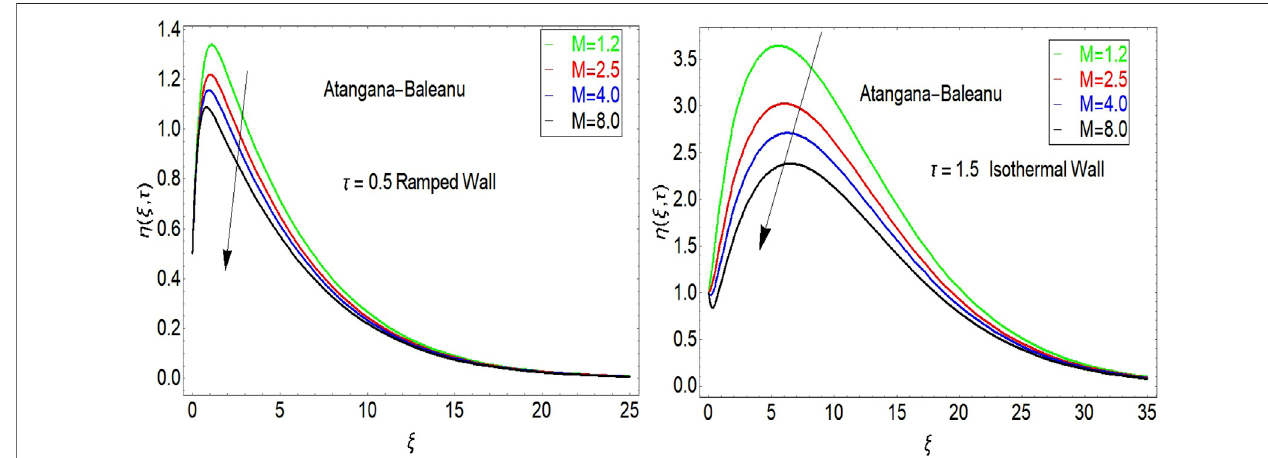
FIGURE 4 | In fl uence of M on velocity for constant and ramped temperature.